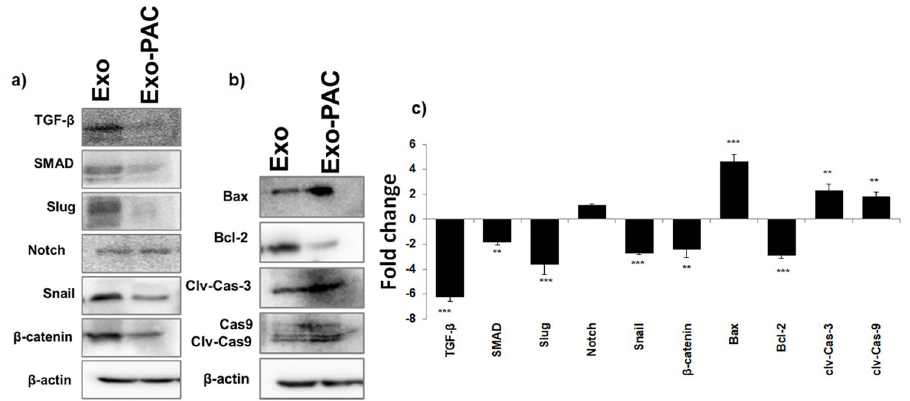
Fig 4. Western blotting protein expression changes a) Band image of EMT-related proteins, b) Band image of apoptosis-related proteins, c) Fold change